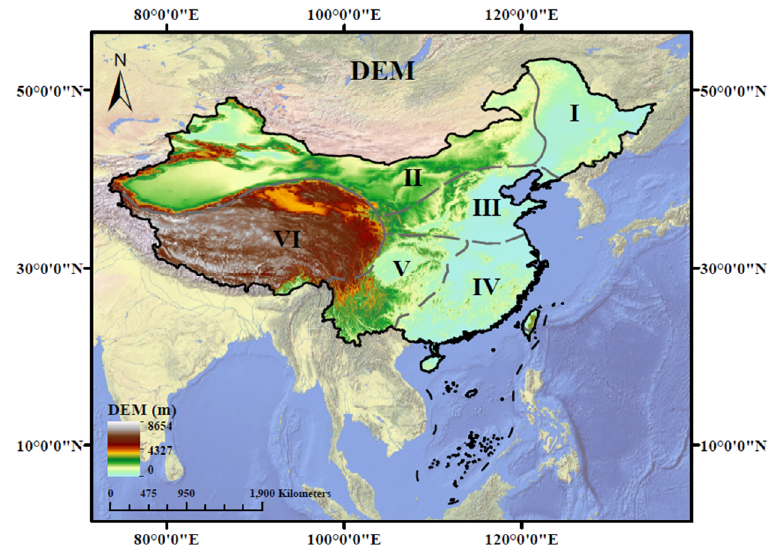
Figure 4. A case study of China. I: Northeast China, II: Northwest China, III: North China, IV: southeast China, V: Southwest China, and VI: Qinghai–Tibet. (1) SM retrieval.